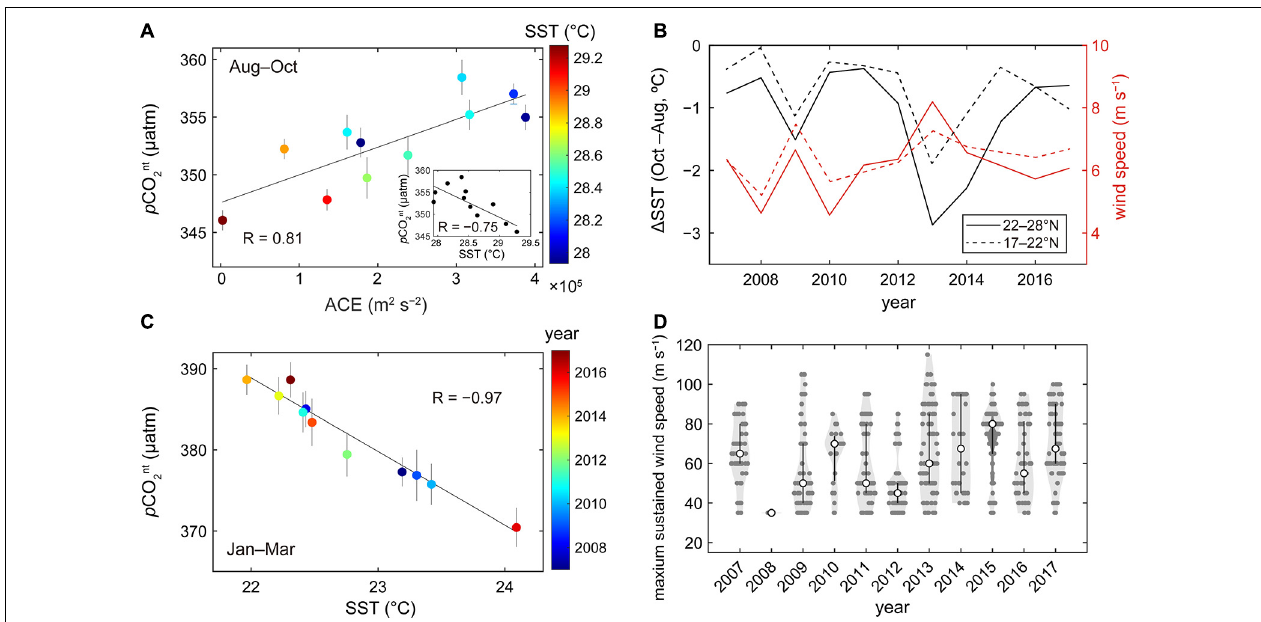
FIGURE 4 | (A) The relationship between the accumulated cyclone energy (ACE) index (m 2 s − 2 ) and the mean p CO 2 nt values over the study region (22 ◦ N–28 ◦ N, 135 ◦ E–145 ◦ E) during TC months (August–October). The color bar represents the mean SST values and the vertical gray lines indicate the 95% confidence interval from the mean p CO 2 nt . The inset shows the relationship between the mean p CO 2 nt and SST during the same period. (B) A comparison of the SST decrease (October–August) with the average wind speed (m s − 1 ) obtained from the gridded product over the study region (22 ◦ N–28 ◦ N, 135 ◦ E–145 ◦ E; solid lines) and a tropical area (17 ◦ N–22 ◦ N, 135 ◦ E–145 ◦ E; dashed lines). (C) The relationship between the mean p CO 2 nt and SST during winter (January–March). The color bar represents the year and the vertical gray lines indicate the 95% confidence interval from the mean p CO 2 nt . Each dot in (A,C) represents an annual mean value calculated from the data collected during August–October and January–March of a given year, respectively. (D) The maximum sustained wind speed of TCs during TC months. The white dots represent the median values of the maximum sustained wind speed (gray dots) from the reported 6-h-interval TC